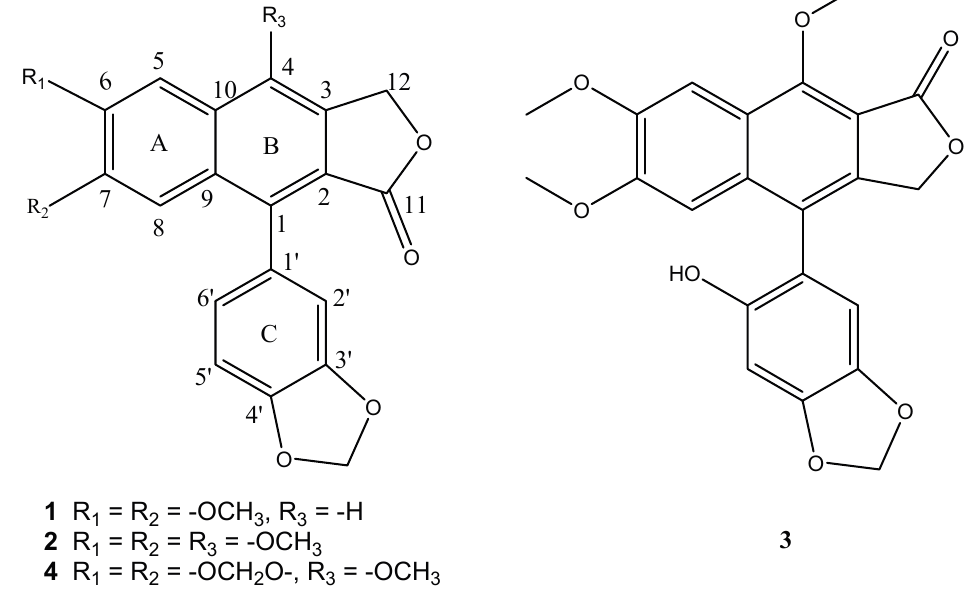
Figure 1. Chemical structures of justicidin B ( 1 ), justicidin A ( 2 ), 6'-hydroxyjusticidin C ( 3 ) and lignan J 1 ( 4